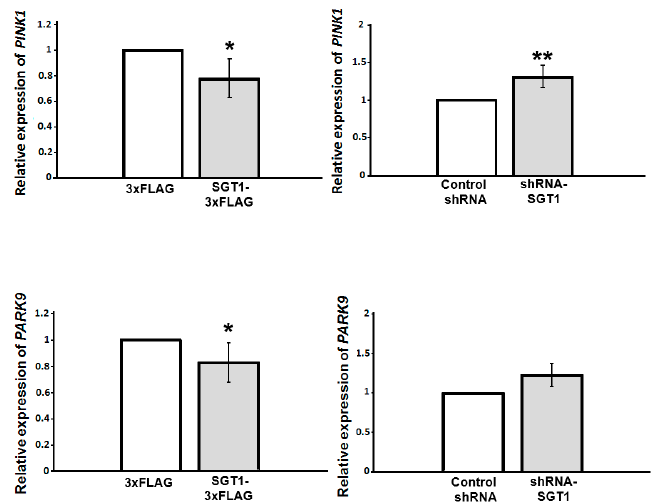
Figure 5. Relative mRNA expression of PINK1 (upper panels) and PARK9 (lower panels) in HEK293 cells. Left panels—control cells (3 × FLAG) or cells overexpressing SGT1 (SGT1-3 × FLAG) and right panels—control cells (control shRNA) or cells with diminished SGT1 level (shRNA-SGT1). Statistical analysis of the results obtained from three independent experiments. * p ≤ 0.05; ** p ≤ 0.01.